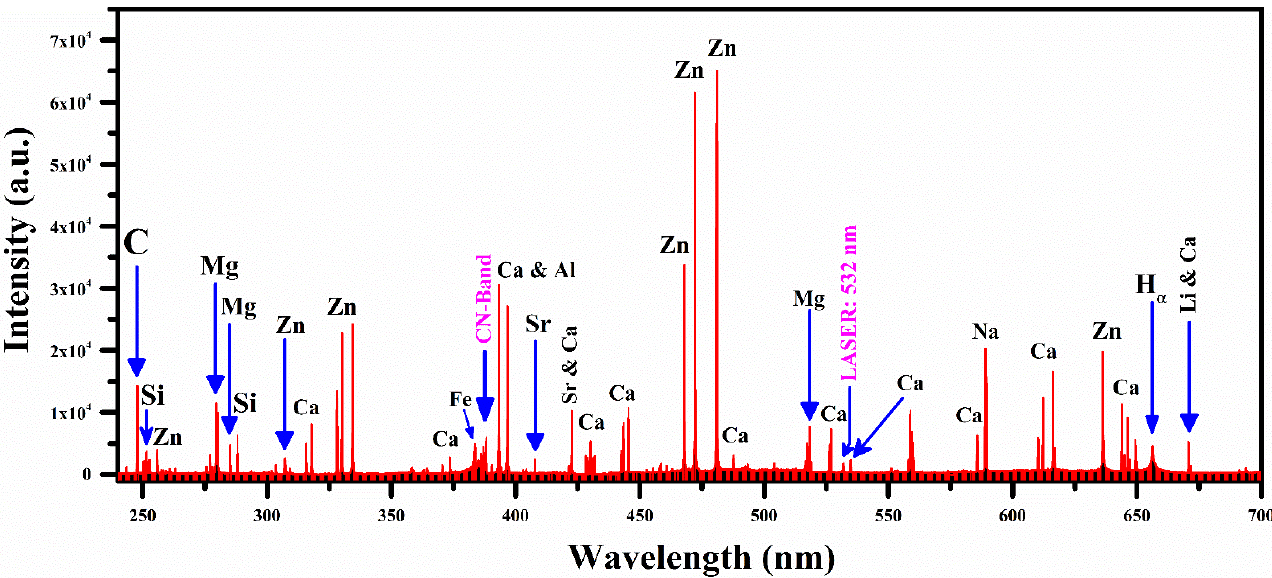
Figure 2. The plasma emission spectrum of the plant-biochar sample (S1) in wavelength ranges from 240 to 700 nm. Table 1. Major emission lines detected in the emission spectrum of the plant-biochar sample (S1).